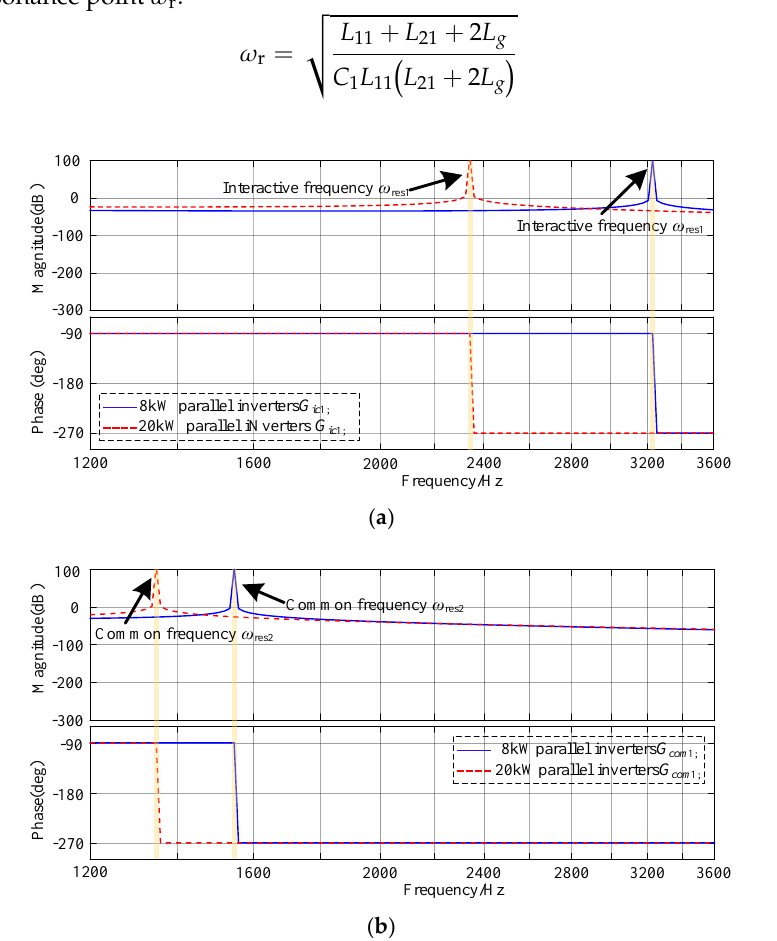
Figure 8. Amplitude frequency characteristics of parallel system with the same capacity. ( a ) The Bode diagram of interactive current G ic ; and ( b ) the Bode diagram of common current G com .